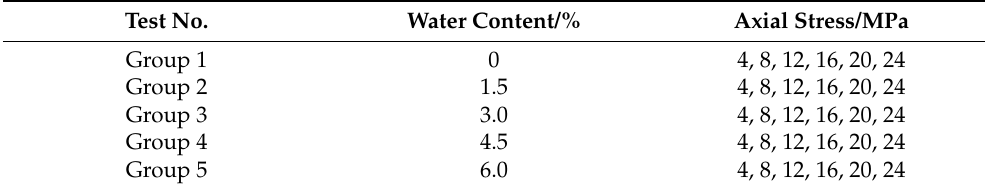
Table 2. Confined compaction experimental scheme of crushed gangue under different water content